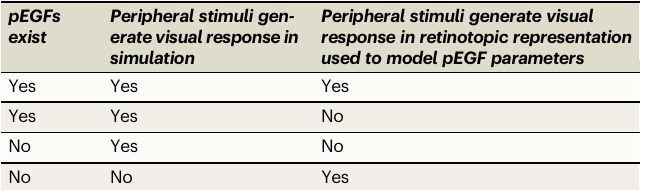
Table 1 | Simulation scenario ’ s pEGFs